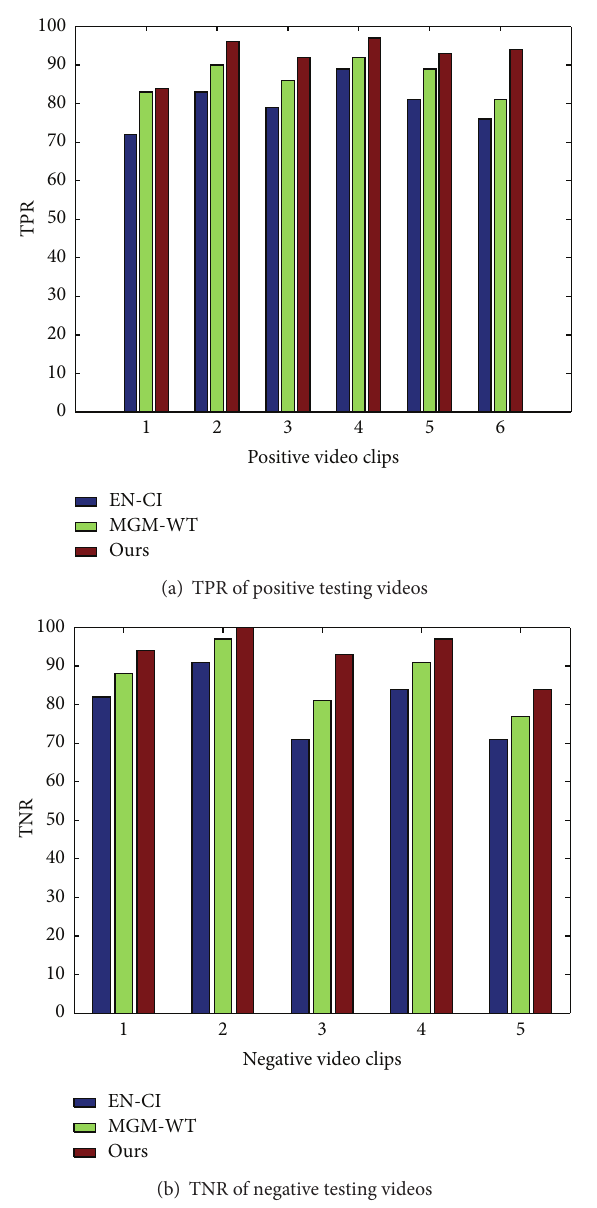
Figure 6: Experimental results of different smoke detection meth- ods in terms of TPR and TNR of each testing